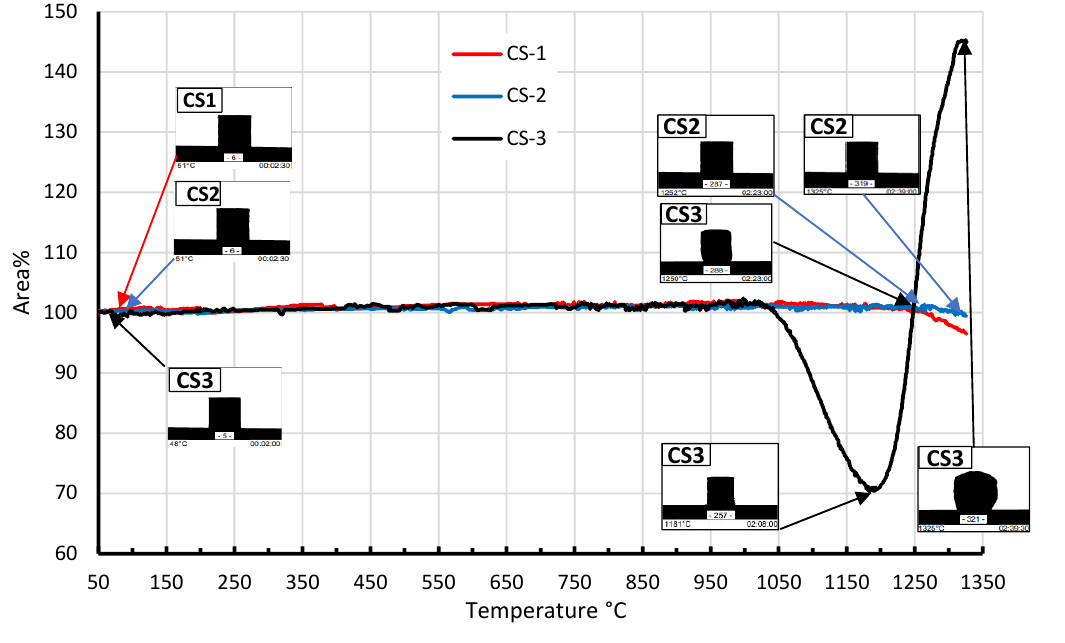
Figure 9. CS1, CS2 and CS3 2D- dilatometry curves in the 50‒1325 °C temperature interval.